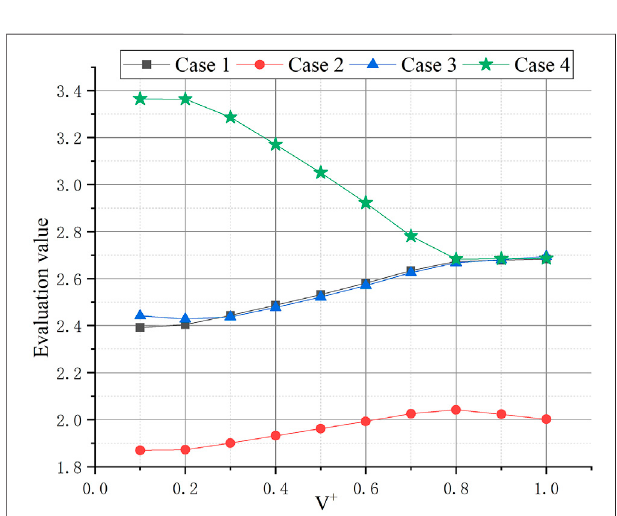
FIGURE 6 | The in fl uence of different V − on the dynamic evaluation results of each scheme when V + (cid:1) 1 . 0.